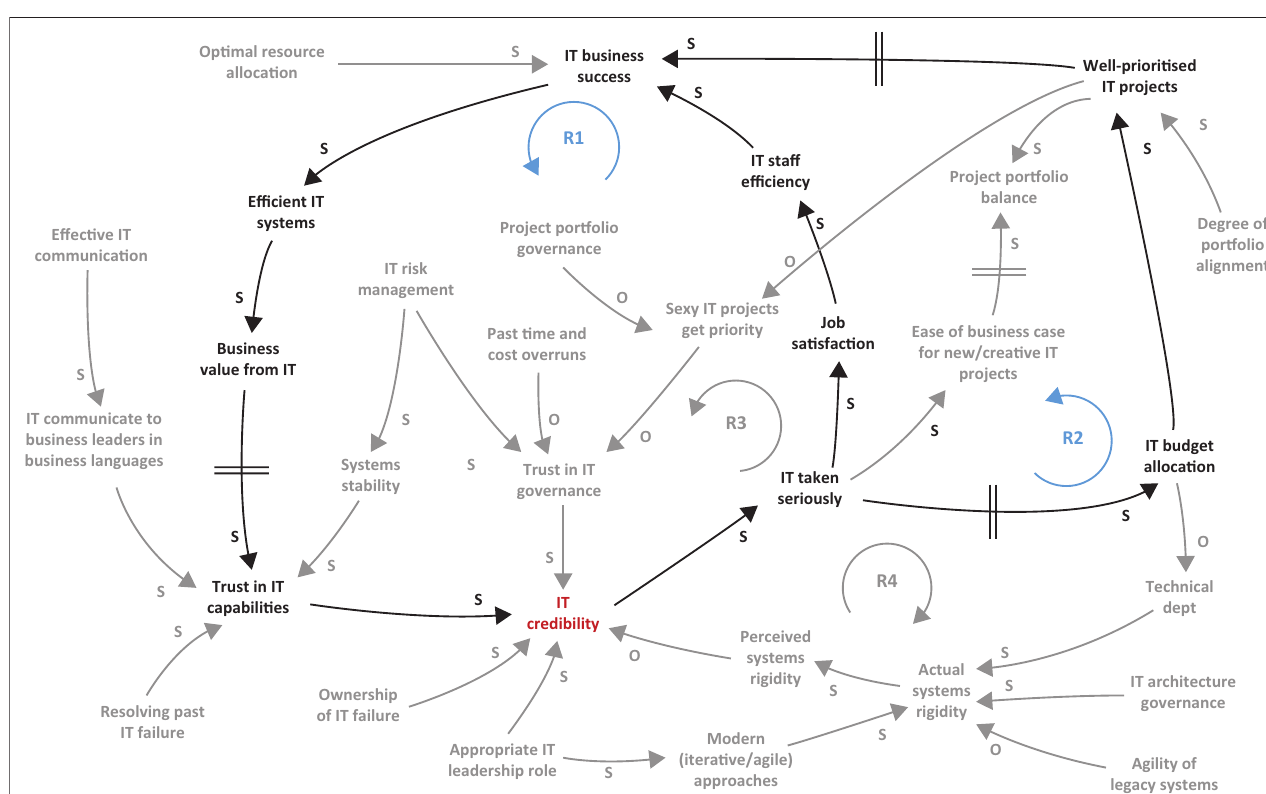
FIGURE 3: Information technology credibility diagram.